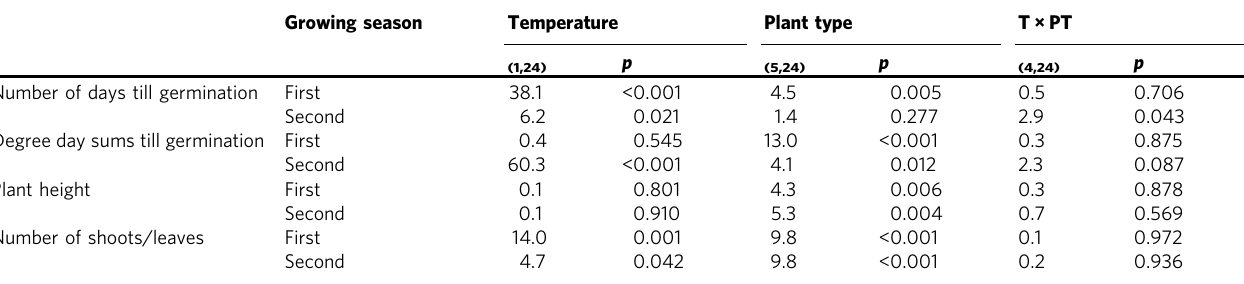
See Supplementary Table 1 for the full species list and Supplementary Tables 2 – 4 for species-speci fi c responses. Degrees of freedom are presented in brackets for each main factor and the interaction term. The signi fi cant Temperature×Plant type (T×PT) interaction was due to a difference (Tukey HSD p <0.05) between rushes (at 2°C) and grasses (at